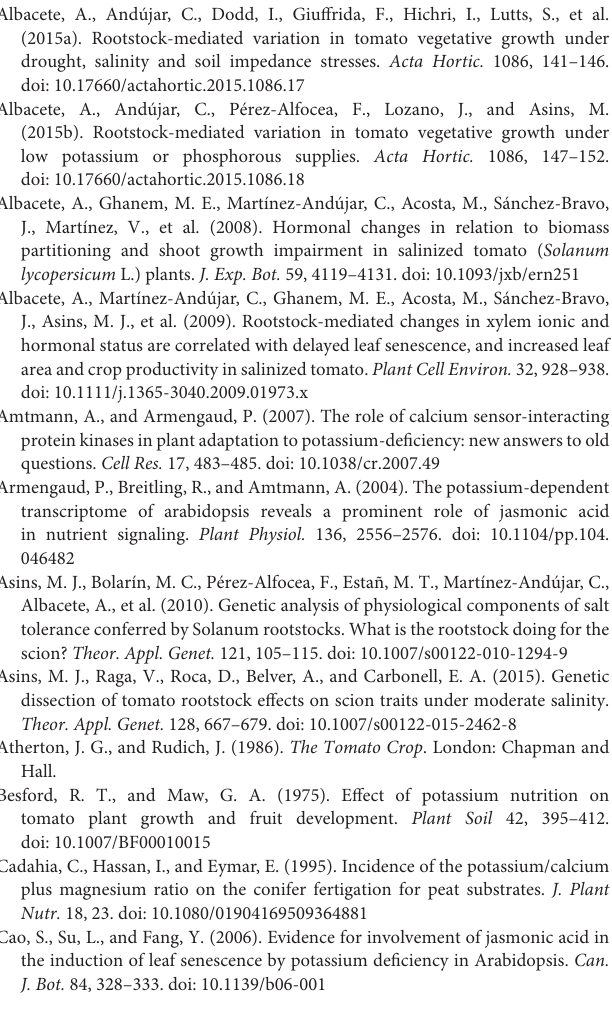
across between Solanum lycopersicum × Solanum pimpinellifolium . Lines enclosed by circles indicate the selected grafted lines within each group used in this study. H, high vigor; L, low vigor; c, control conditions; k, low K conditions. ∗∗ P < 0.01. Figure S2 | Sap flow of the scion ( Solanum lycopersicum cv. Boludo F1) grafted onto a population of recombinant inbred lines (RILs) from a cross between Solanum lycopersicum × Solanum pimpinellifolium with high (H) or low (L) vigor growing under standard (c) and low K (k) conditions during 48 days. Different letters indicate significant differences among graft combinations ( n = 12, P < 0.05) within each treatment. ∗ indicate significant differences between control and K-deprived plants accoding to the Tuckey test ( P < 0.05). Figure S3 | Giberellin A1 (GA1) (A) , gibberellin A3 (GA3) (B) gibberellin A4 (GA4) (C) and total gibberellins (Total GAs) (D) concentrations in xylem sap of the scion ( Solanum lycopersicum cv. Boludo F1) grafted onto a population of recombinant inbred lines (RILs) from a cross between Solanum lycopersicum × Solanum pimpinellifolium with high (H) or low (L) vigor growing under standard (c) and low K (k) conditions during 48 days. Different letters indicate significant differences among graft combinations ( n = 12, P < 0.05) within each treatment. ∗ indicate significant differences between control and K-deprived plants according to the Tuckey test ( P <